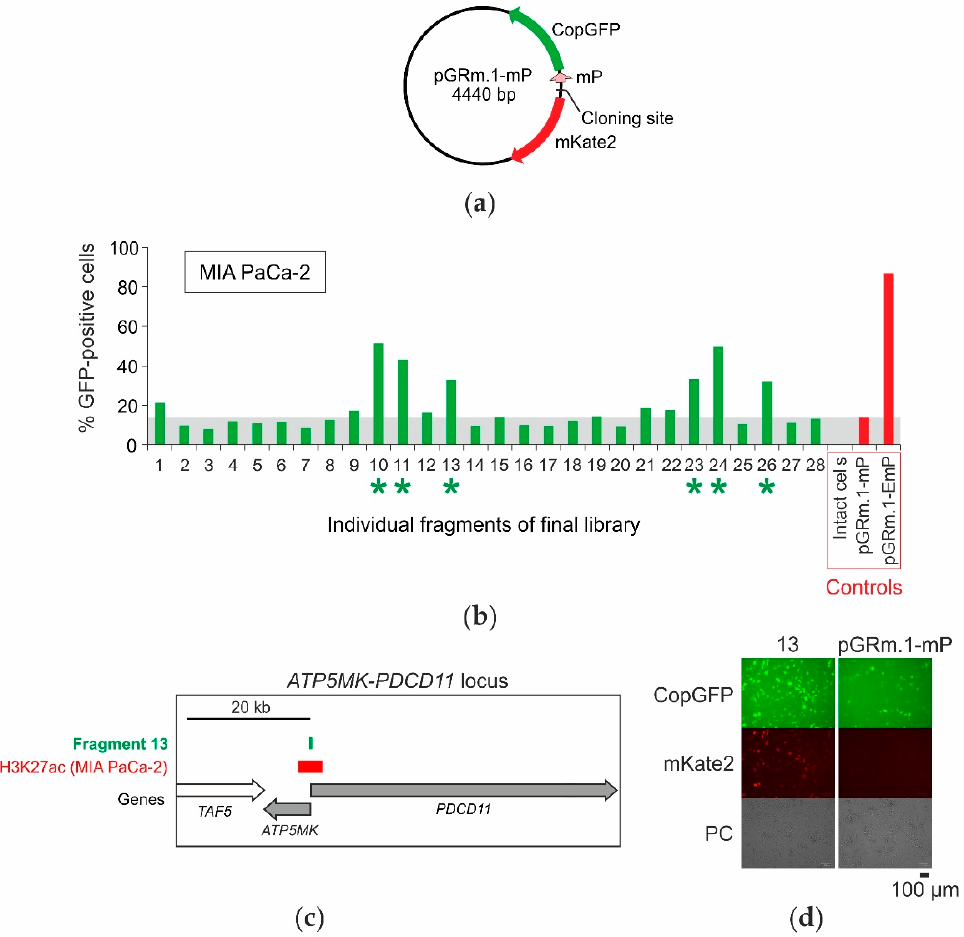
Figure 3. Functional analysis of individual fragments of the resulting library by the bidirectional reporter gene pair assay in transient expression system and MIA PaCa-2 cells. ( a ) Scheme of the pGRm.1-mP plasmid designed to analyze the enhancer/promoter activity of DNA fragments in transiently transfected cells. ( b ) Library of fragments isolated from GFP-positive cells was cloned into the pGRm.1-mP plasmid, twenty-eight plasmids were transfected into MIA PaCa-2 cells. Six of the 28 fragments (21%) were active in MIA PaCa-2 cells (marked with green asterisks). The gray band corresponds to the proportion of GFP-positive cells in the population transfected with the original pGRm.1-mP plasmid. pGRm.1-EmP is a control plasmid containing a CMV minimal promoter and CMV enhancer. ( c ) Fragment #13 mapped to the bidirectional promoter of the ATP5MK and PDCD11 genes pair (right) and overlaps with the H3K27Ac-enriched region in Mia PaCa-2 cells. ( d ) Micrographs of MIA PaCa-2 cells transfected with pGRm.1-mP plasmid with fragment #13 and control enhancerless plasmid. PC—phase contrast. Table 1. Sequenced and mapped DNA fragments from L1 library.